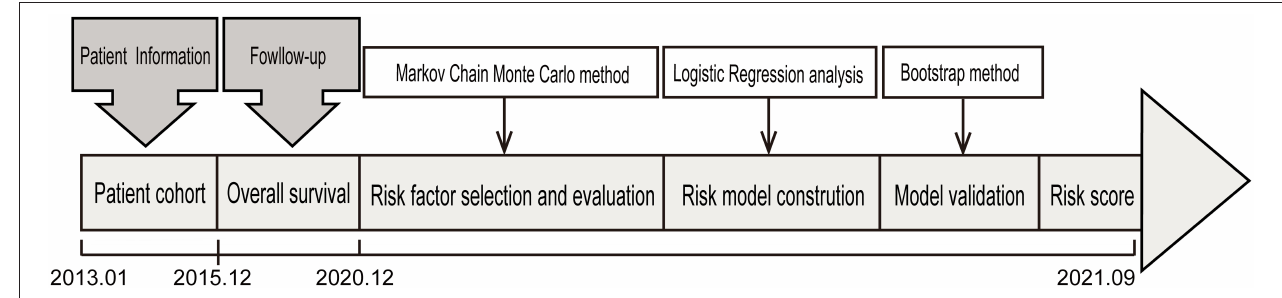
FIGURE 1 | The design of the study. The patient cohort including 153 patients with newly diagnosed OS after a strict pathological diagnosis and exclusion process was used to identify prognostic factors for in-hospital mortality and was used for further evaluation and validation analysis.